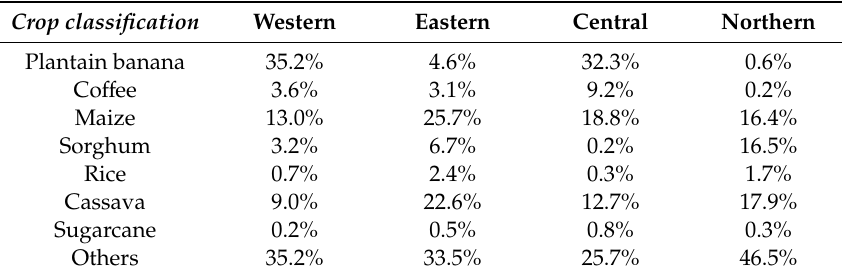
Table 1. Cultivated crop shares per